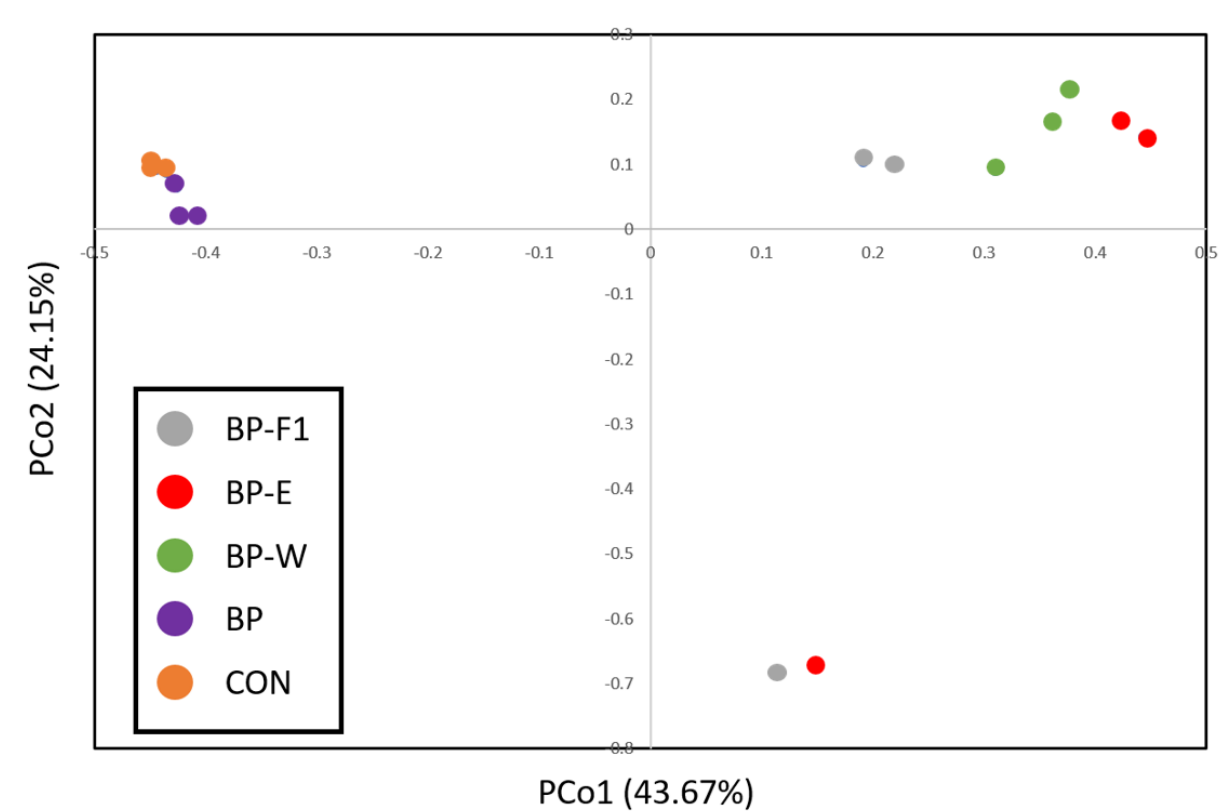
Figure 2. Comparison of intestinal bacterial communities in hybrid striped bass for five dietary treatments (BP-F1, BP-E, BP-W, BP, and CON). Principal Coordinate Analysis (PCoA) was performed based on the Bray–Curtis distance matrix. The x and y axes correspond to Principal Components 1 (PCo1) and 2 (PCo2), respectively, which together explained 67.82% of the variance. The PERMANOVA test supported the separation of samples into different groups ( p = 0.001), but differences between groups could not be resolved by pairwise comparisons ( p >